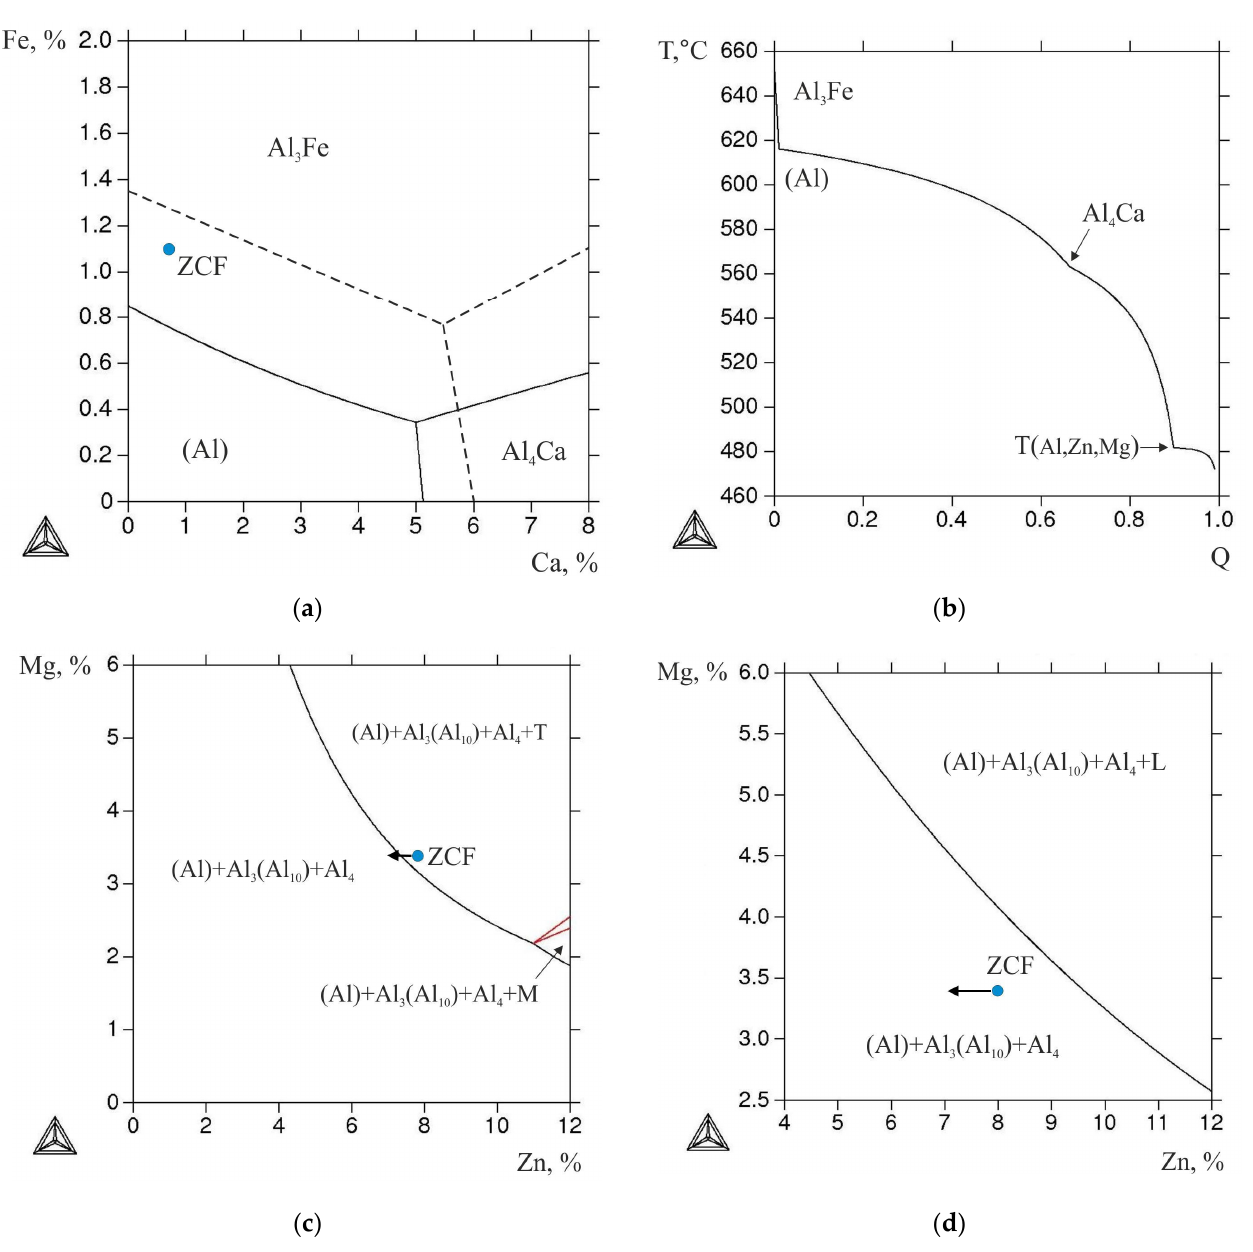
Figure 7. Calculated fragments of Al–Zn–Mg–Ca–Fe phase diagram (position of experimental alloy CZF is shown): ( a ) liquidus projection at 8%Zn and 3.3%Mg; ( b ) dependence of mass fraction of solid phases (Q) versus temperature (Sheil–Gulliver simulation) for alloy ZCF; ( c ) isothermal section at 0.8%Ca, 1.1%Fe, and 450 °C; ( d ) isothermal section at 0.8%Ca, 1.1%Fe, and 500 °C.